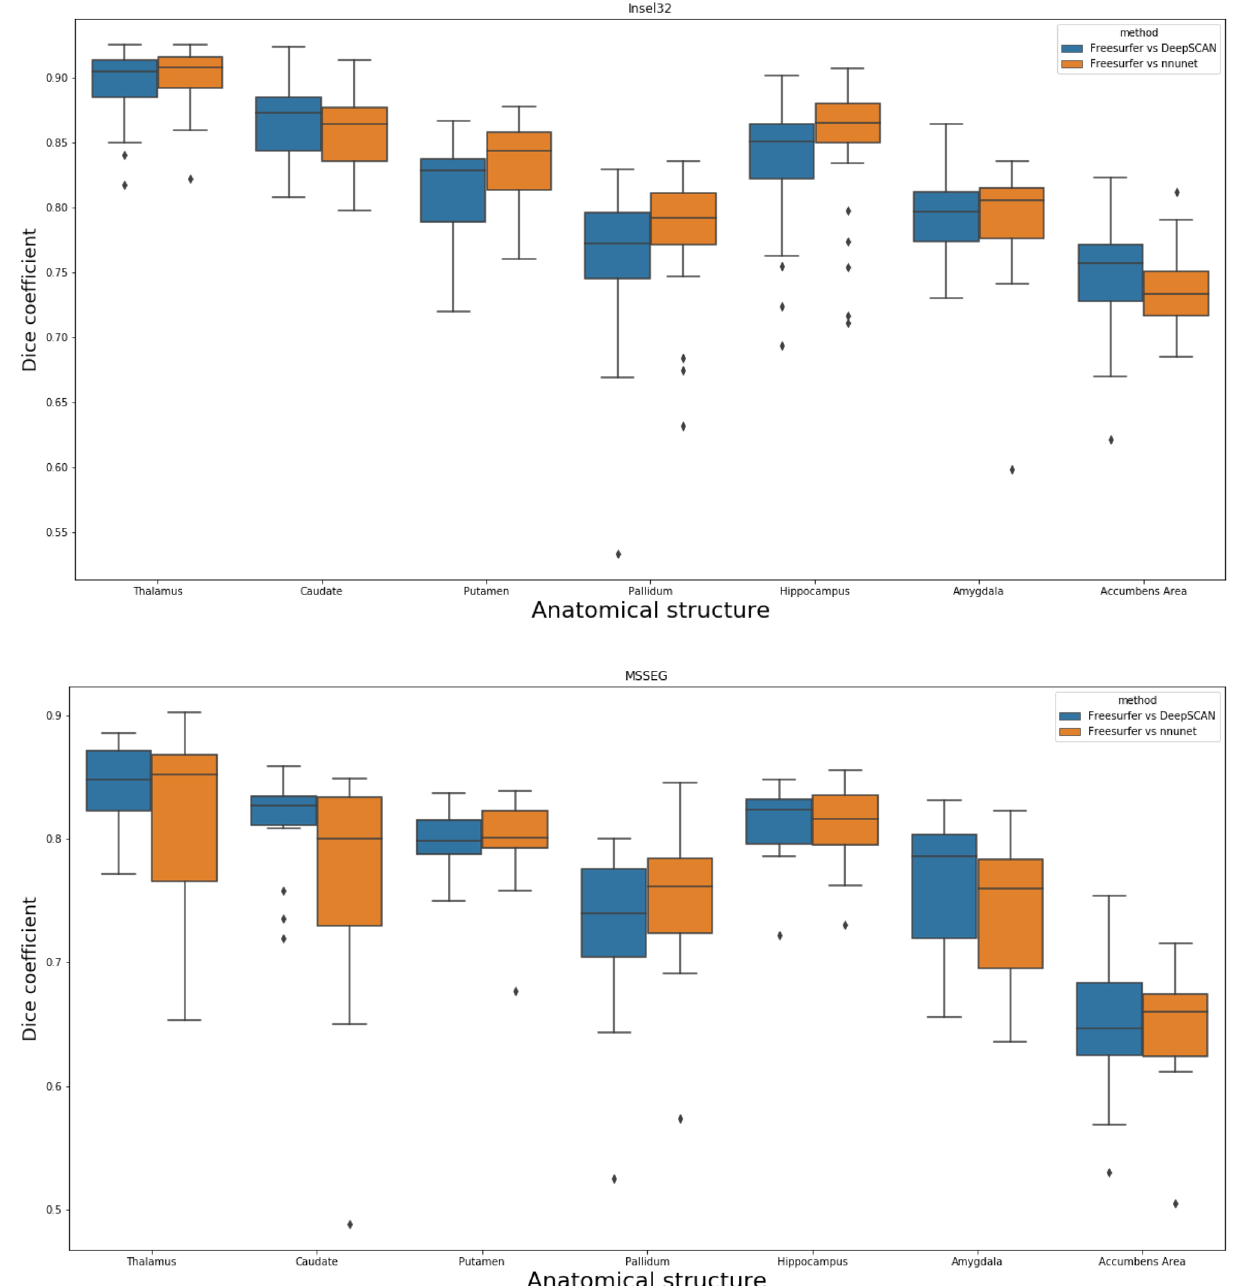
Figure 3. Boxplots of Dice coefficients for selected grey matter structures, for classifiers trained on the Insel90 dataset, and validated on the Insel32 (in sample) and MSSEG (out of sample)